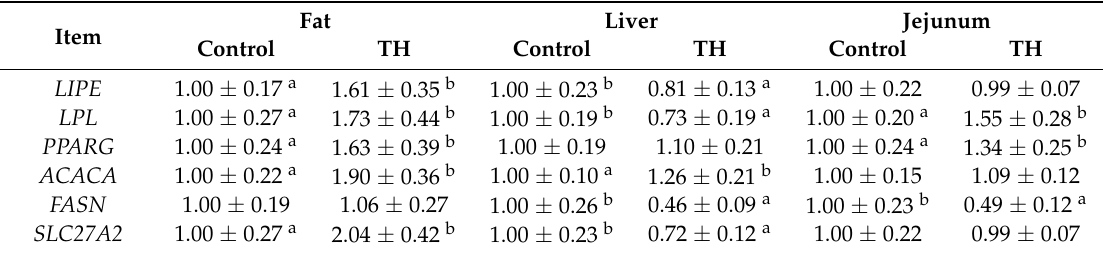
Table 4. Relative expression levels of genes associated with fat metabolism in tissues of piglets receiving dietary supplementation with or without trihexanoin (TH).